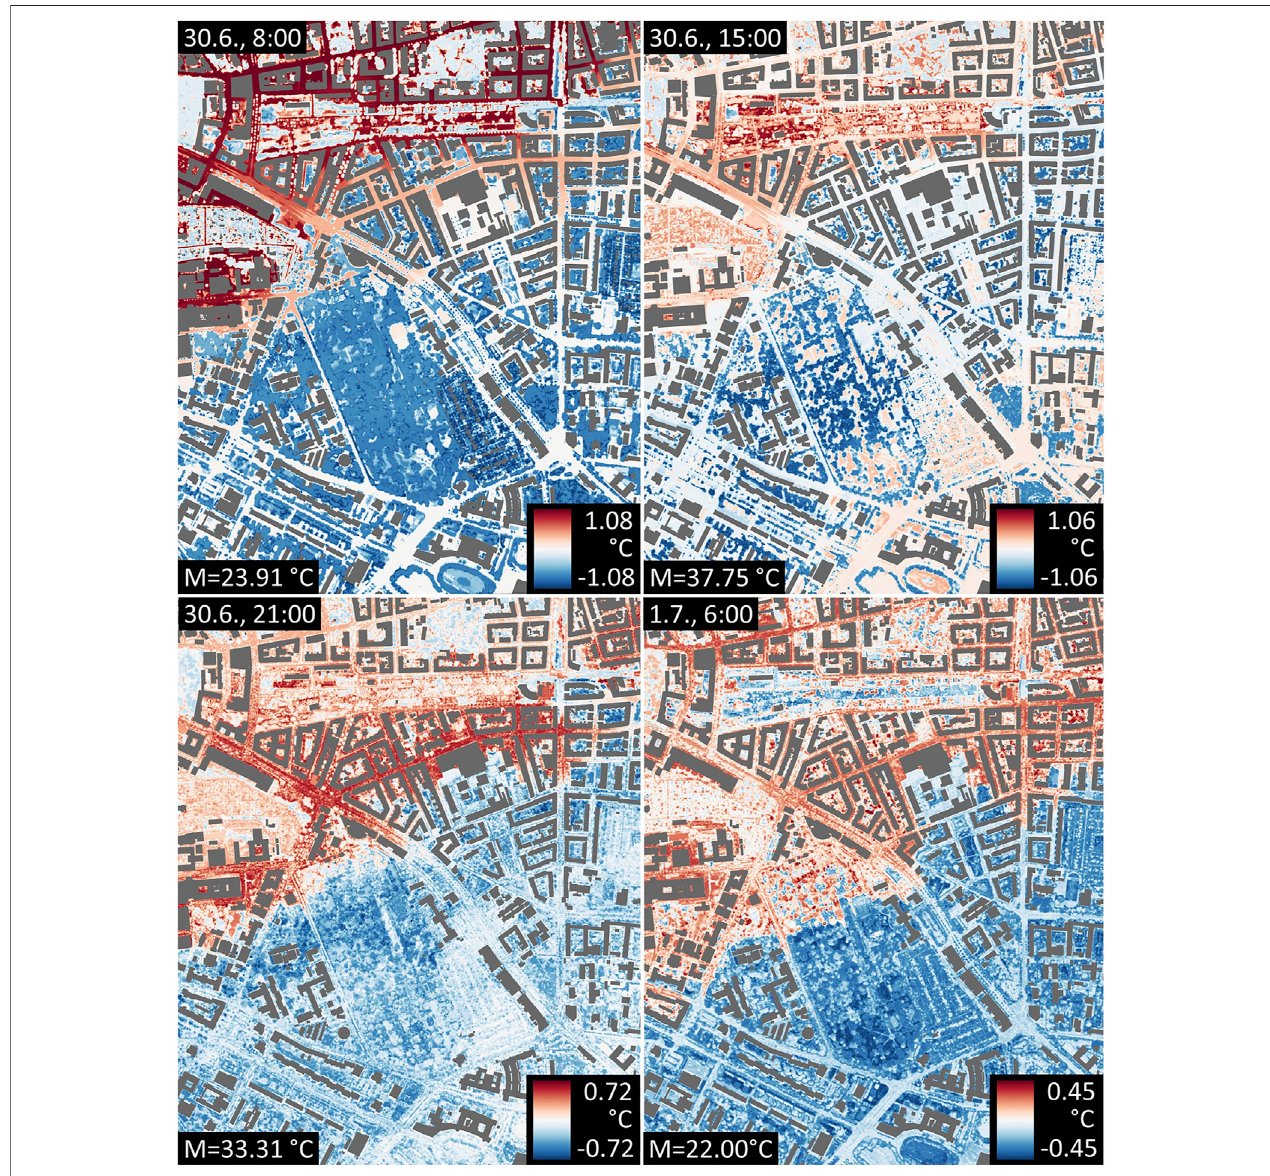
FIGURE 5 | Air temperature maps for the four selected points in time depicting deviation from respective mid-range values (central value between minimum and maximum), indicated by M. For representation of absolute values, please see Supplementary Material S3 .